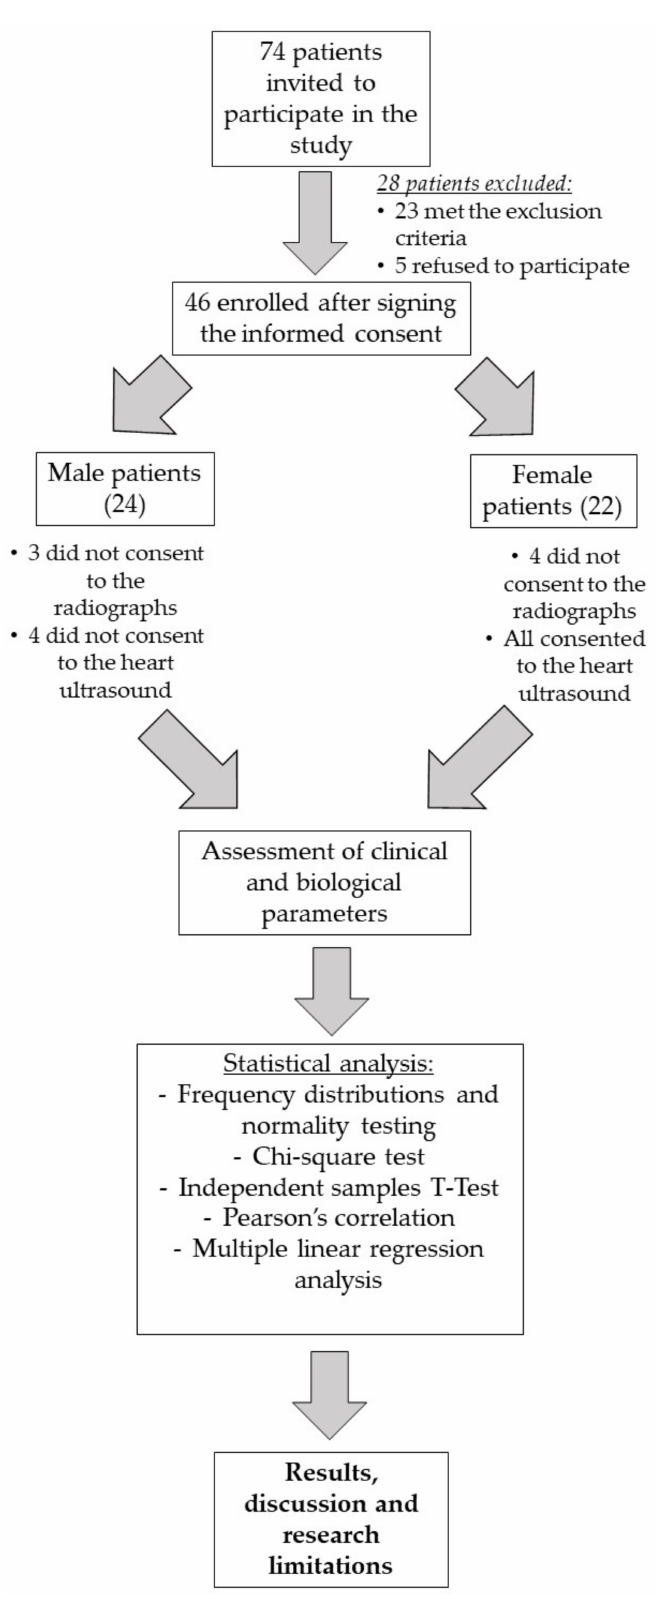
Figure 1. Design of the